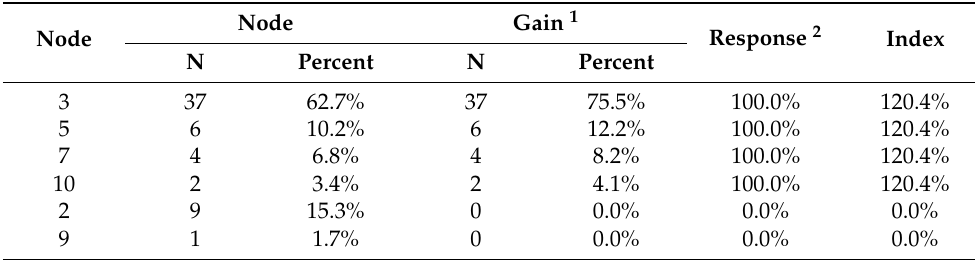
Table 8. CART—Gains for Nodes.